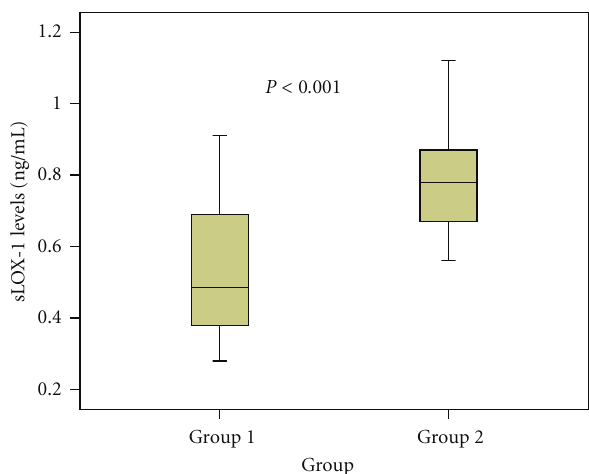
Figure 1: The comparison of sLOX-1 levels between two groups (Group 1: pregnancy followed by delivery group, Group 2: non- gravidity group. Soluble LOX-1 levels were 0 . 78 ± 0 . 13ng/mL in nongravidity group and 0 . 52 ± 0 . 18ng/mL in pregnancy followed by delivery group, P < 0 . 001).